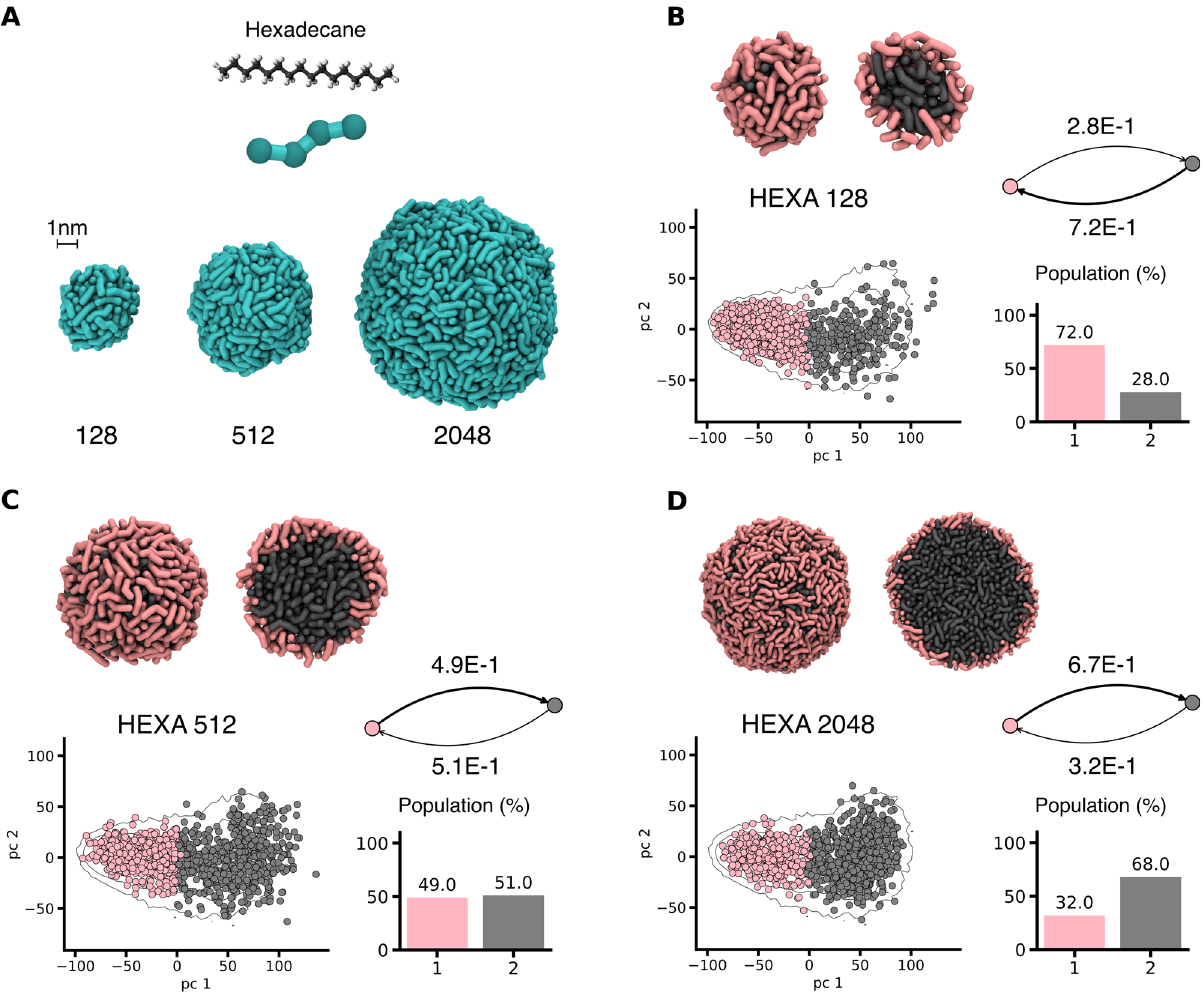
Fig. 5 Comparing 3D assemblies. We consider three homogeneous nanoparticle-like structures of different size (composed of a different number of HEXA monomers). A Chemical structure and CG model representation of HEXA monomers and growing size nanoparticles. B – D SOAP + PAMM analysis of the three spherical assemblies formed by a different number of monomers ( B : 128, C : 512 and D : 2048 HEXA). Each panel shows (left to right) an equilibrium MD snapshot of the aggregate (entire and in section), the PCA scatter plot of SOAP feature vectors, the molecular motif interconversion graph and the macroclusters population histogram. The colors refer to the molecular environment states detected by